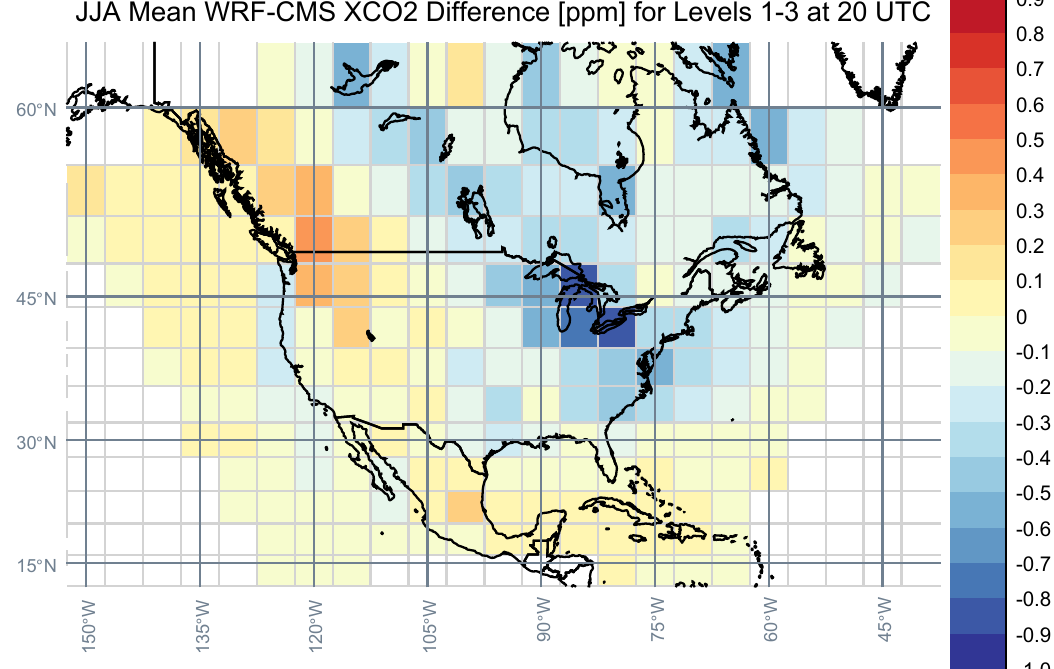
Figure A6. Model-model differences in the lower column (surface to 850 hPa). Compare these results to Figure 6b in the main